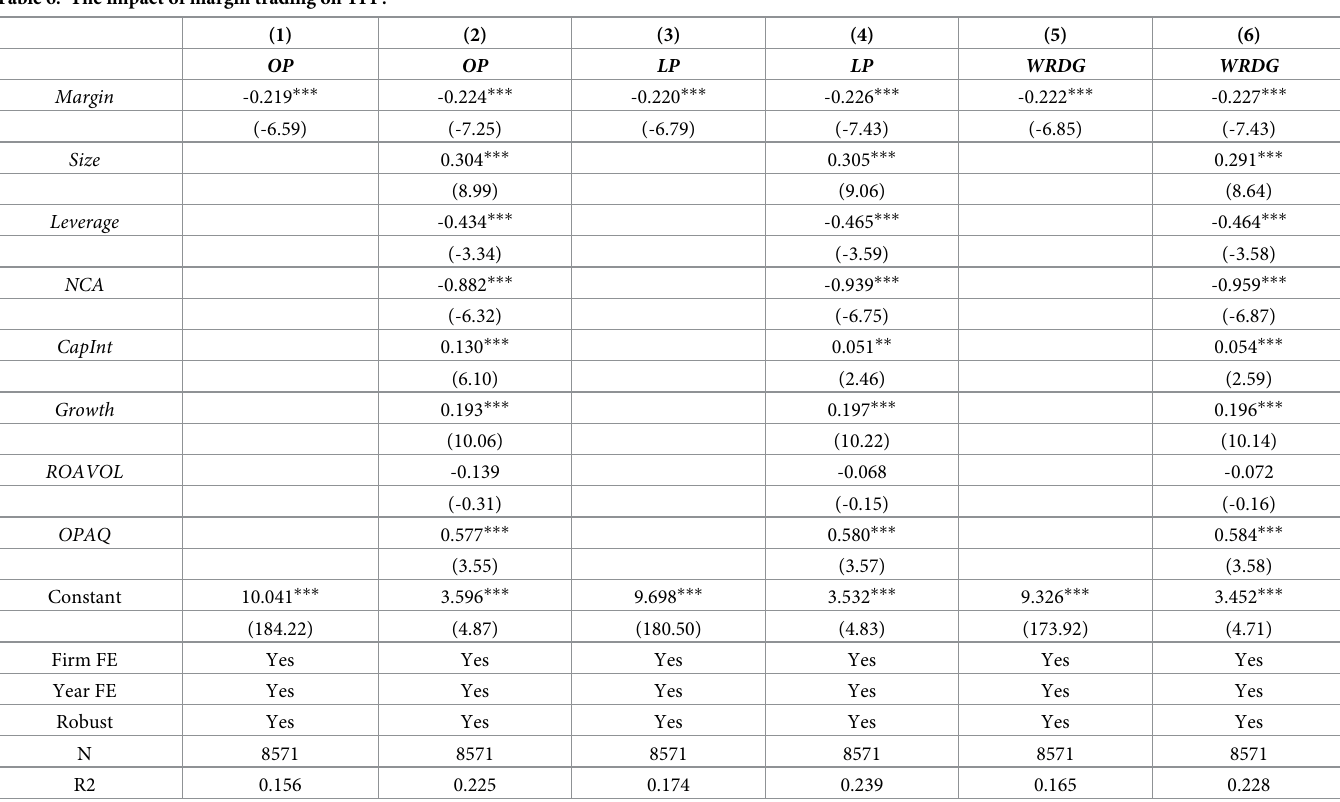
Table 6. The impact of margin trading on